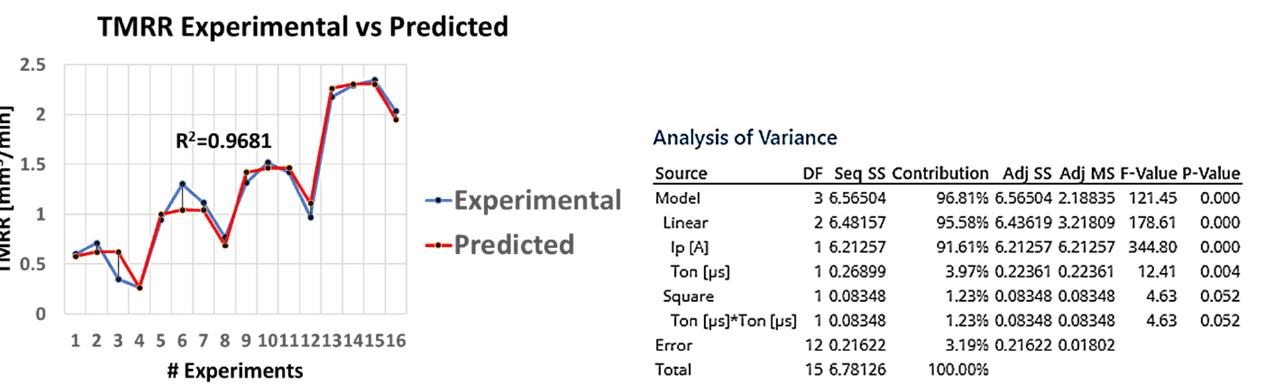
Figure 5. Box plot, interaction plot of TMRR and the results of the Fisher statistically significant test.